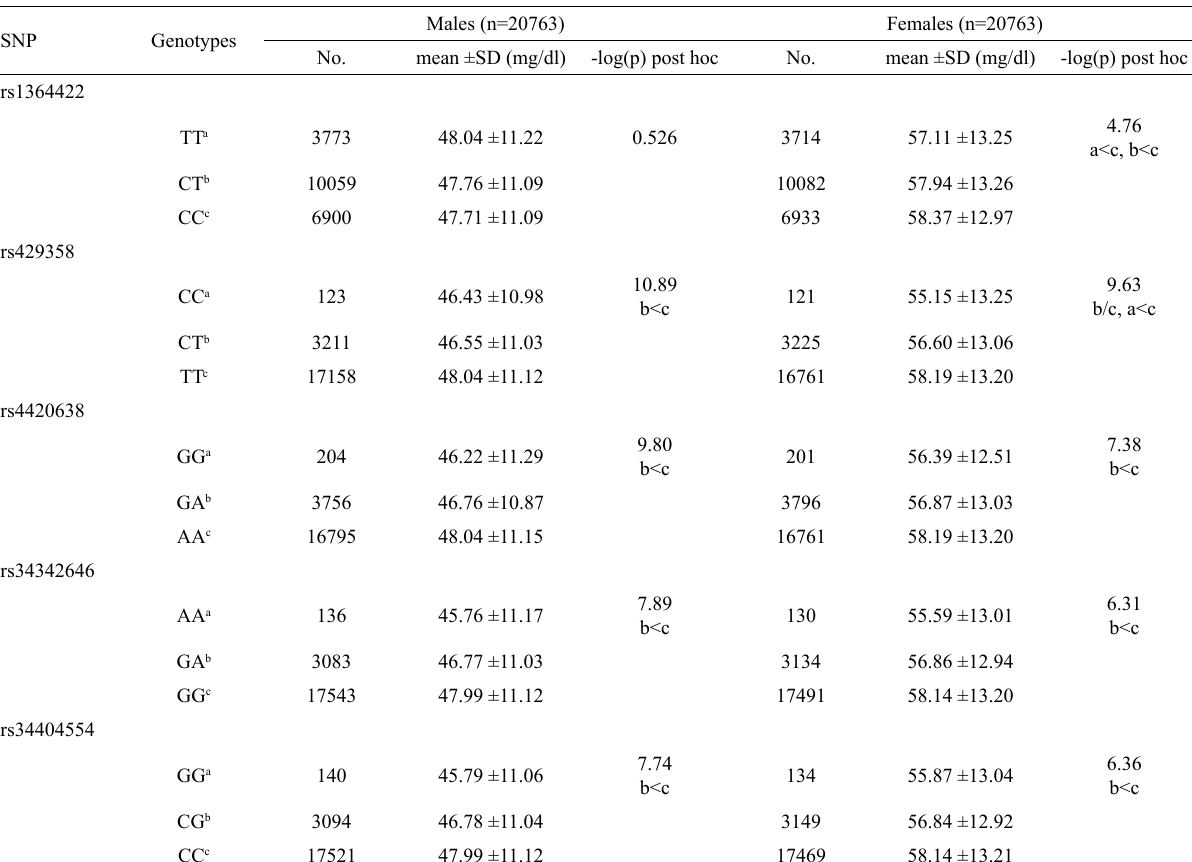
Table 3 – Mean values of HDL-C among the polymorphisms which were sex-specific related to